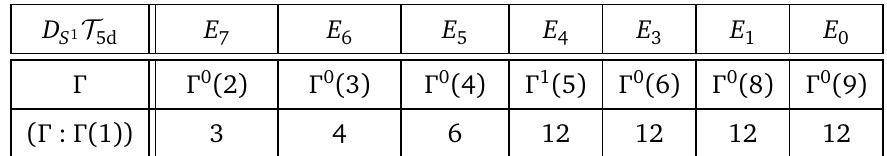
, E and (cid:101) E are not mod- 8 2 1